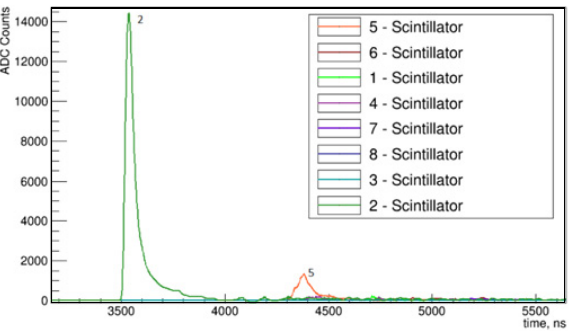
Figure 6. MME as seen by the HT detector system.